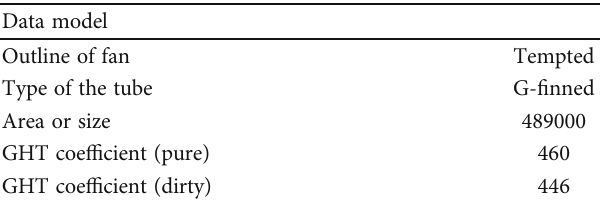
Table 1: Important parameter of cooled condenser. Data